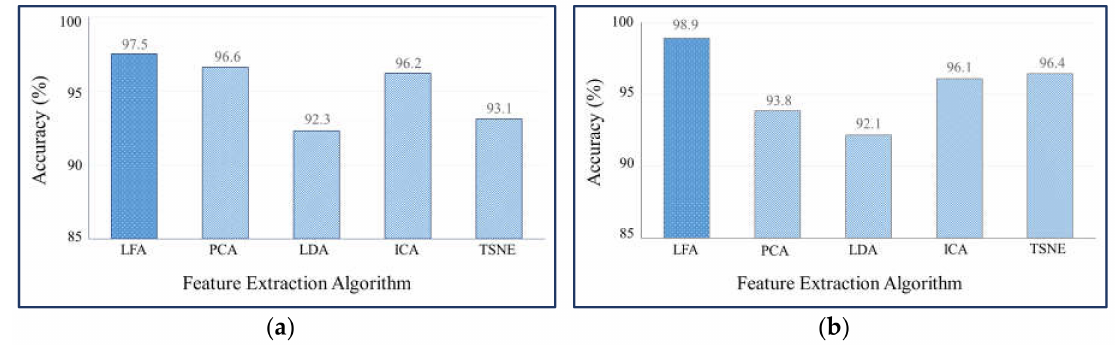
Figure 11. Accuracy measurement data using machine learning. ( a ) Accuracy measurement data using k-nearest neighbors. ( b ) Accuracy measurement data using a support vector